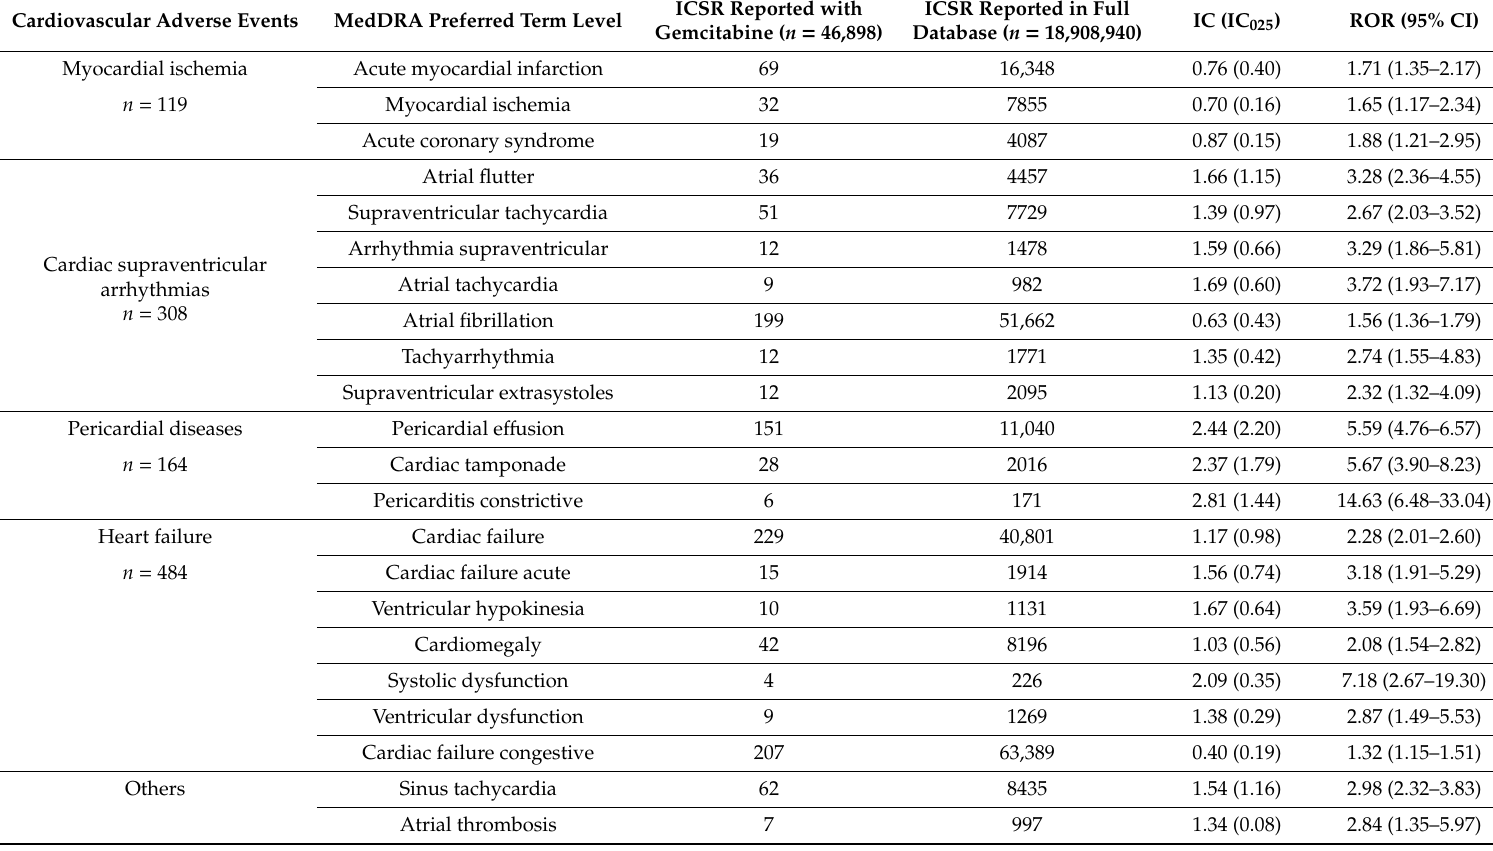
Table 3. Selected cardiovascular adverse drug reactions (CV-ADRs, detected as signals) reported for gemcitabine versus the full database from VigiBase, on 1 April 2019. A positive IC 025 (information component 95% credibility interval lower end) and a reporting odd-ratio (ROR) 95% confidence interval lower-end (95% CI) ≥ 1 are